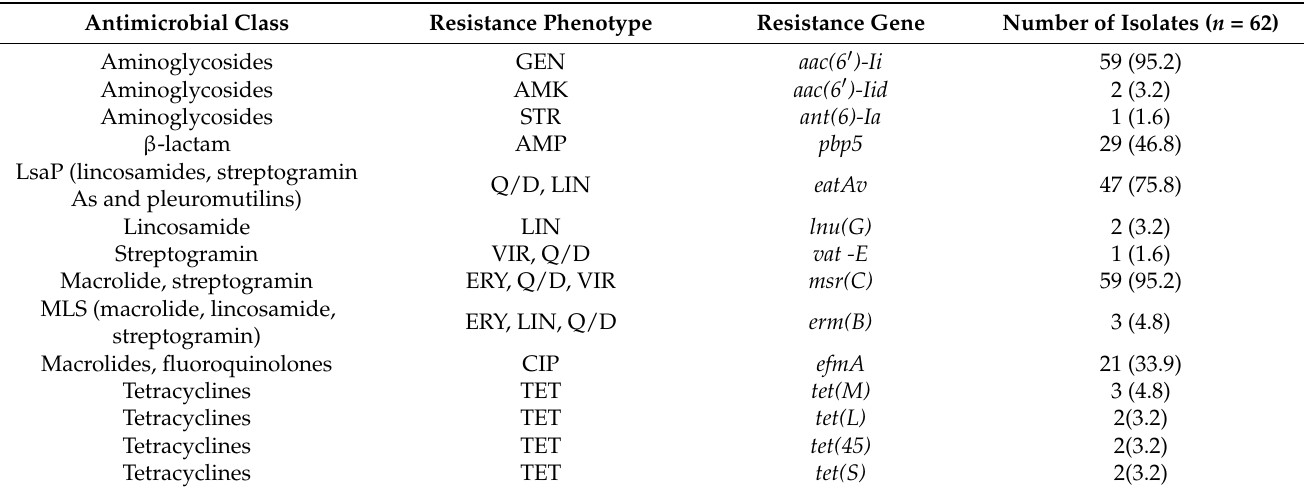
Table 5. The frequency of antimicrobial resistance genes found in 62 E. faecium isolates selected for whole genome